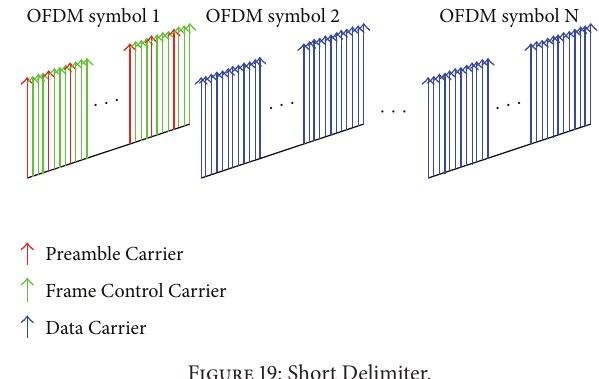
Figure 19: Short